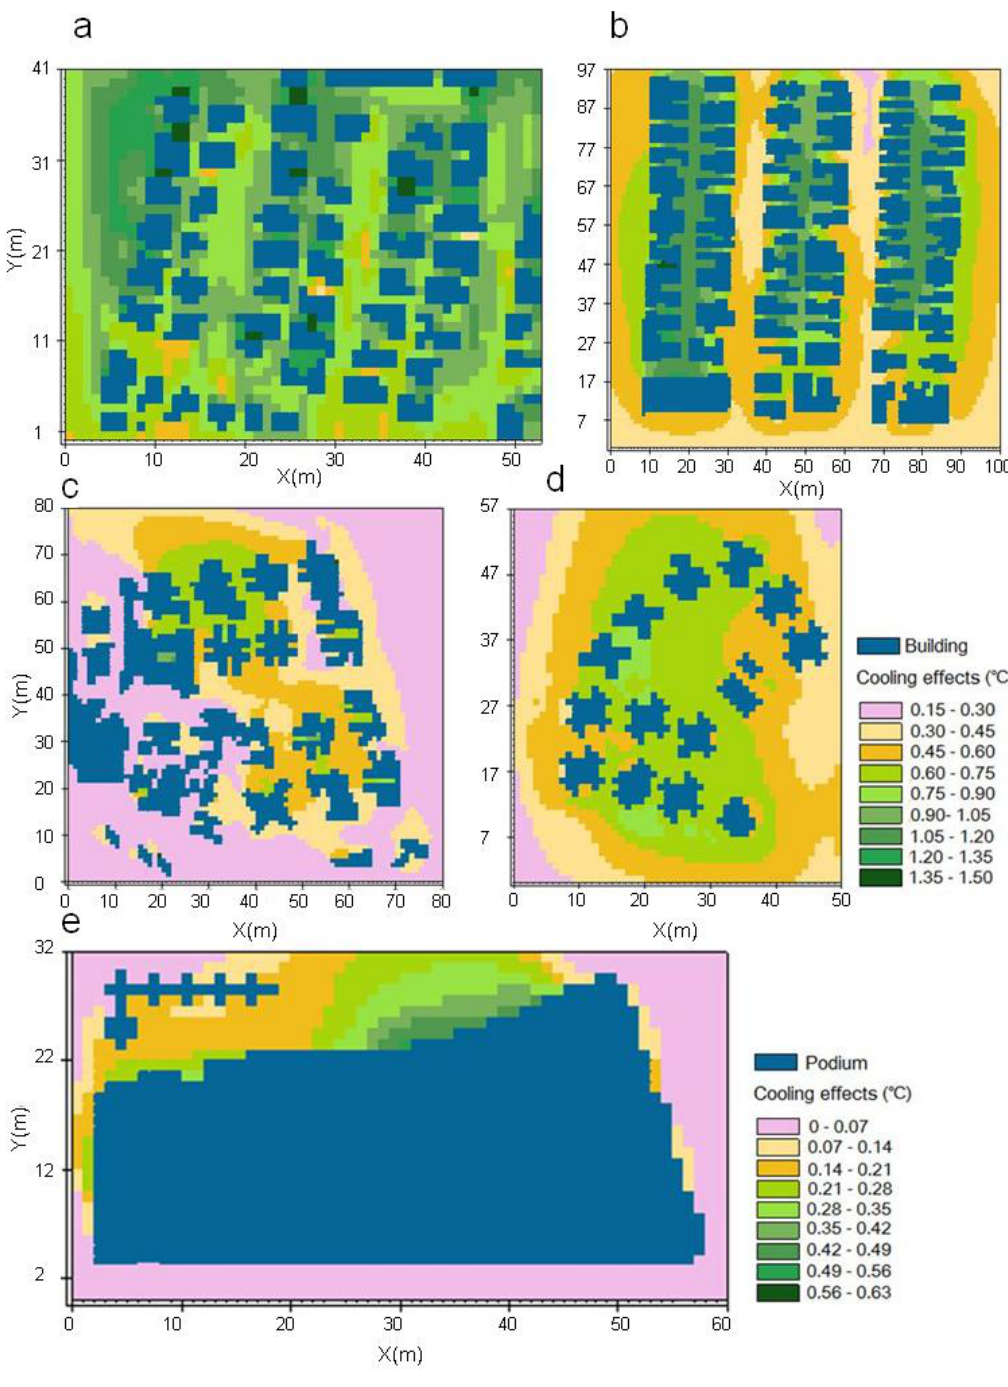
Figure 8. Horizontal distribution of cooling effects for IGR at the pedestrian level at 14:00 (cooling effects refer to the air-temperature differences between the bare and